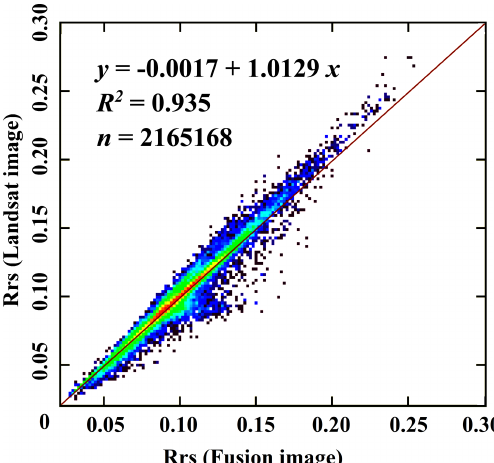
Figure 4. Scatterplot of the real and the predicted reflectance by the ESTARFM for the blue band. The capture date was 22 Novem- ber